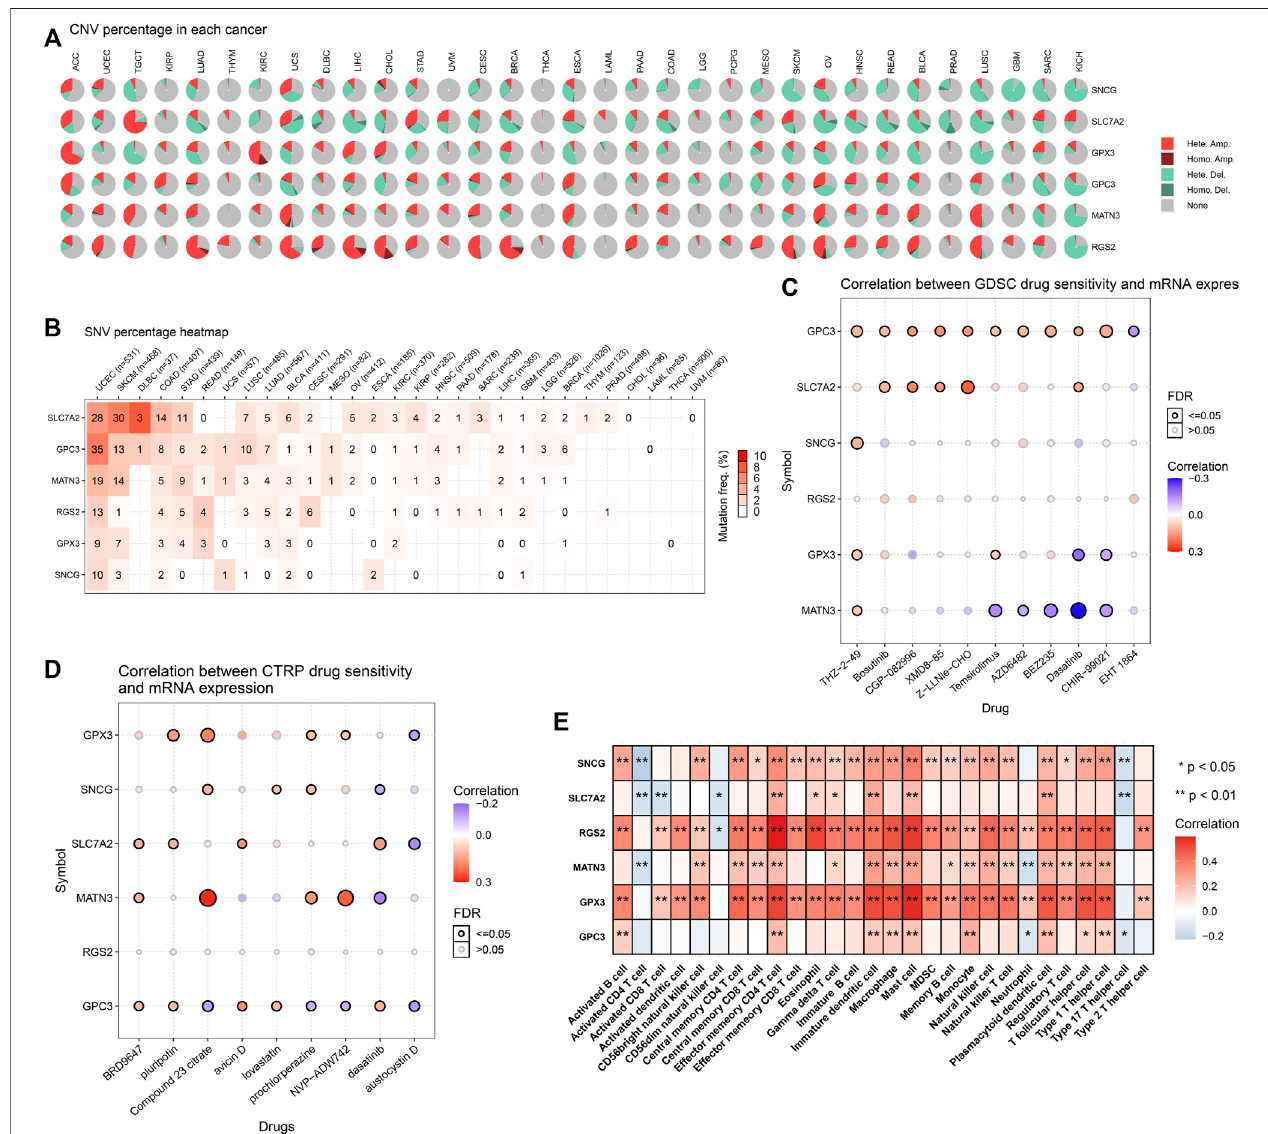
FIGURE 7 | Landscape of genetic alterations, drug sensitivity, and immune cell in fi ltration in the exosome-based gene signature. (A) Percentage of CNVs of each gene in the exosome-based gene signature across pan-cancer. (B) Mutation frequencies of each gene in the signature across pan-cancer. (C) Associations of mRNA expressionofeachgenewithsensitivitytosmallmolecularcompoundsinaccordancewiththeGDSCdatabase. (D) AssociationsofmRNAexpressionofeachgenewith sensitivitytosmallmolecularcompoundsinaccordancewiththeCTRPdatabase. (E) AssociationsofmRNAexpressionofeachgenewithimmunecellin fi ltrationin the